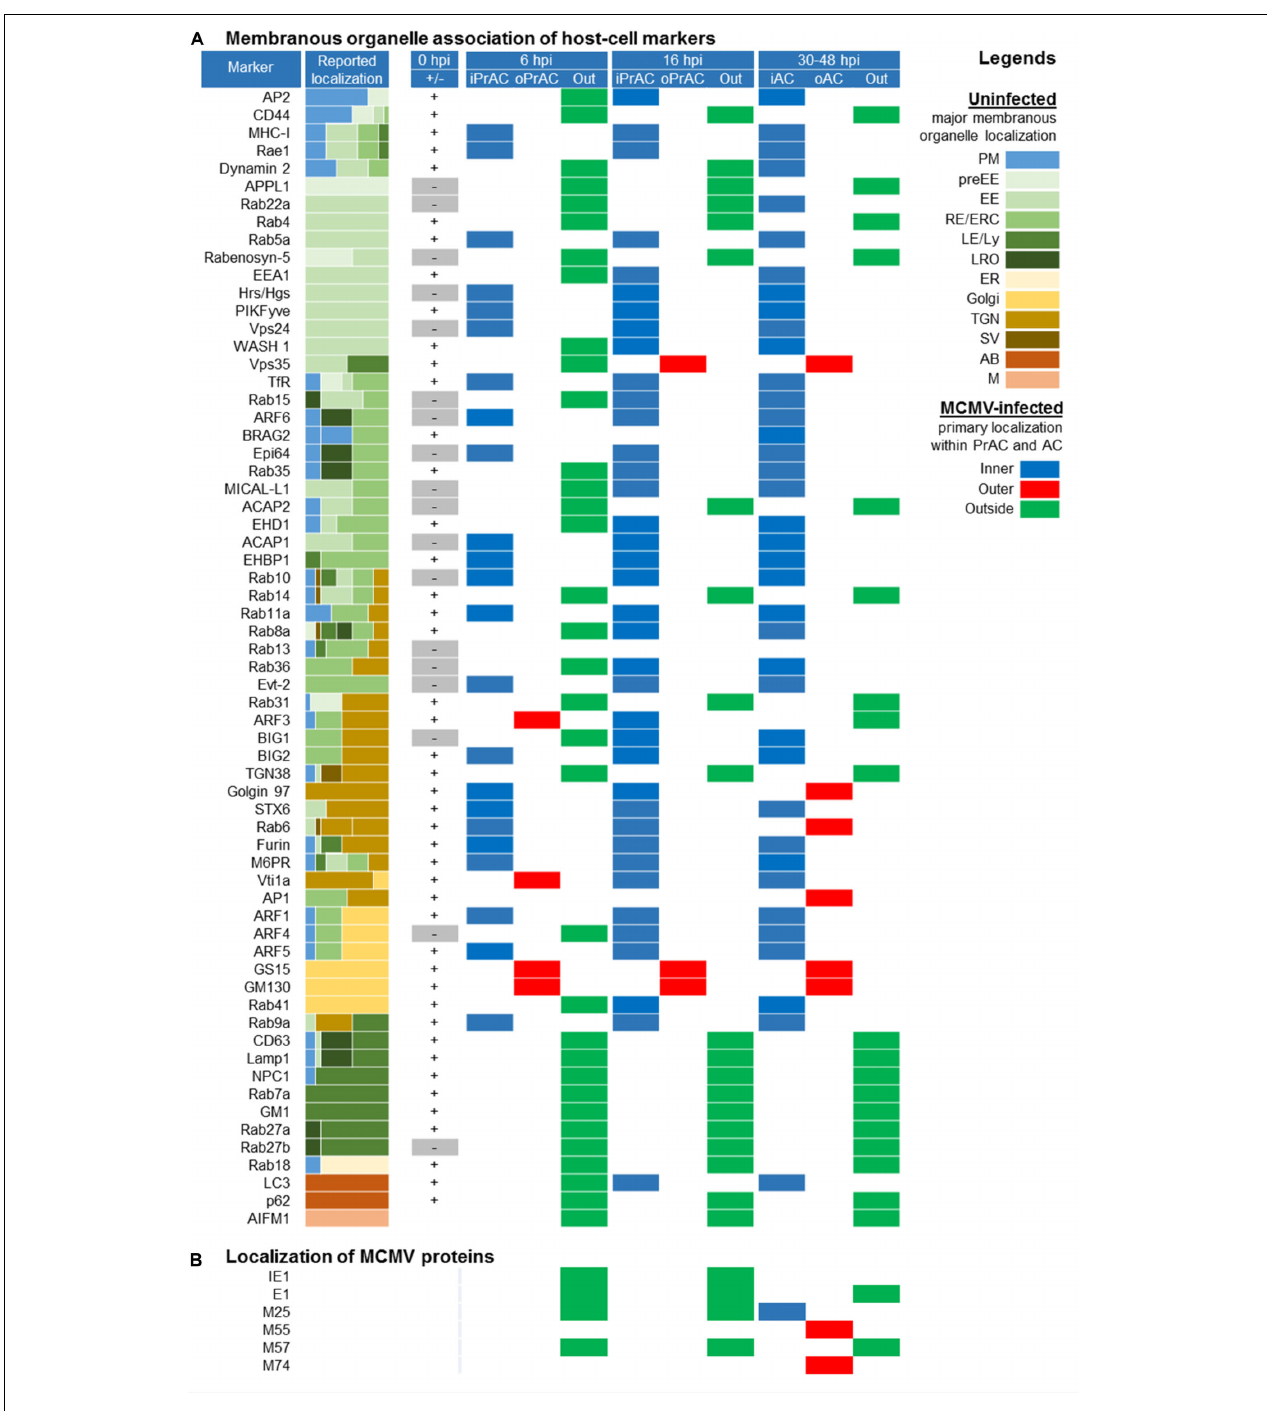
FIGURE 7 | Spatial distribution of membrane markers in the reorganized membranous organelles of the Pre-Assembly Compartment (PrAC) and Assembly Compartment (AC) of MCMV infected cells. (A) Membrane markers are sorted according to the reported localization in the membranous system of the uninfected cell ( Supplementary Table S2 ). The column Reported localization represents the approximate relative distribution of the markers in membranous organelles published in the literature (represented by different colors in the legend on the right). Column 0 hpi ( ± ) represents the absence (–) or the presence (+) of the expression pattern at the distinguishable steady-state organelles of uninfected Balb 3T3 cells ( Supplementary Figures S8–S10, S12, S13, S15, S16 ). Columns 6 and 16 hpi, as well as column > 30, represents the presence and primary (major) distribution of markers at reorganized membranous structures of the infected cells classified as inner and outer PrAC or AC, respectively (legend MCMV-infected). The primary distribution of markers was based on the simultaneous immunofluorescence staining of markers with either GM130 in the E phase of infection (6 and 16 hpi) or viral structural glycoproteins (M55 and M74) in the late phase of infection ( > 30 hpi). (B) Primary localization of MCMV proteins in the course of MCMV infection determined by immunofluorescence analysis. 2-column fitting image.